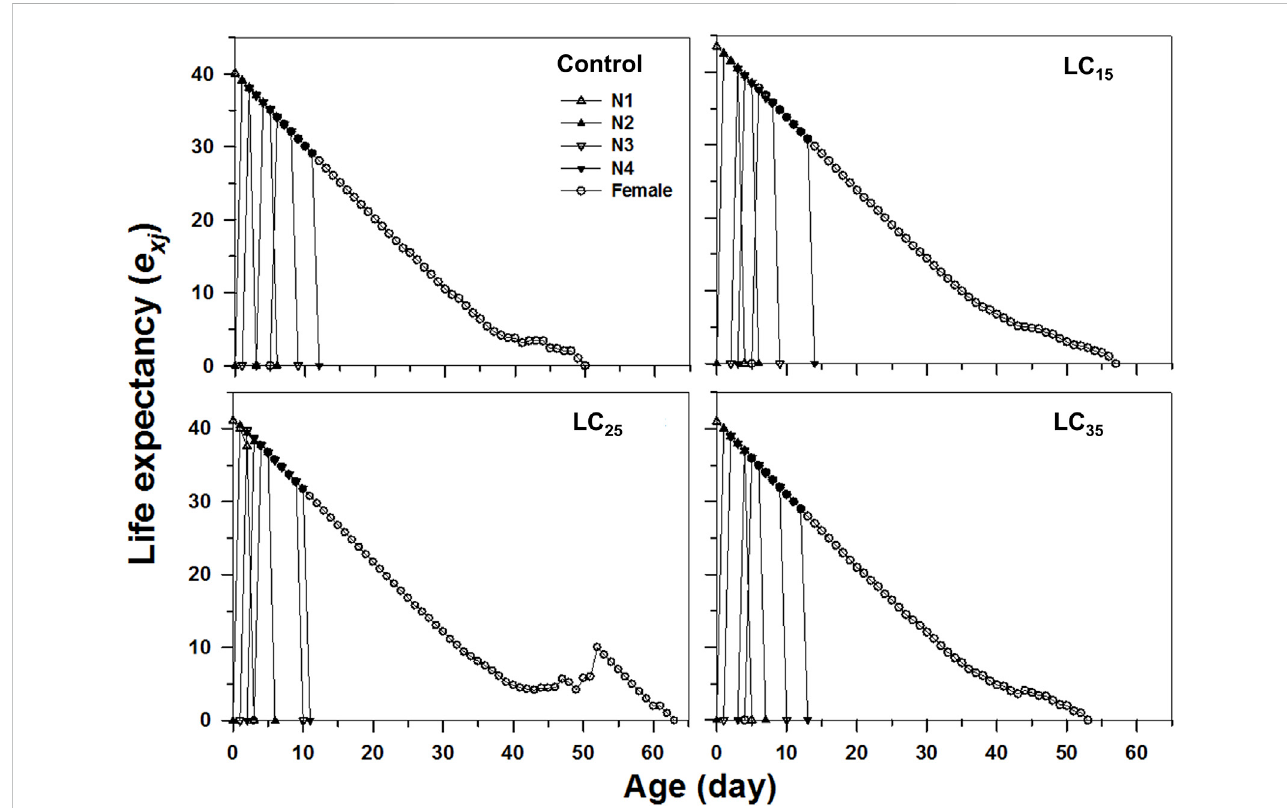
FIGURE 4 Age-stage-specifc life expectancy ( e xj ) of Metopolophium dirhodum individuals of the F1 generation under control conditions, treated with 50 mg/L of imidacloprid (LC 15 ), 100 mg/L of imidacloprid (LC 25 ) and 200 mg/L of imidacloprid (LC 35 ).